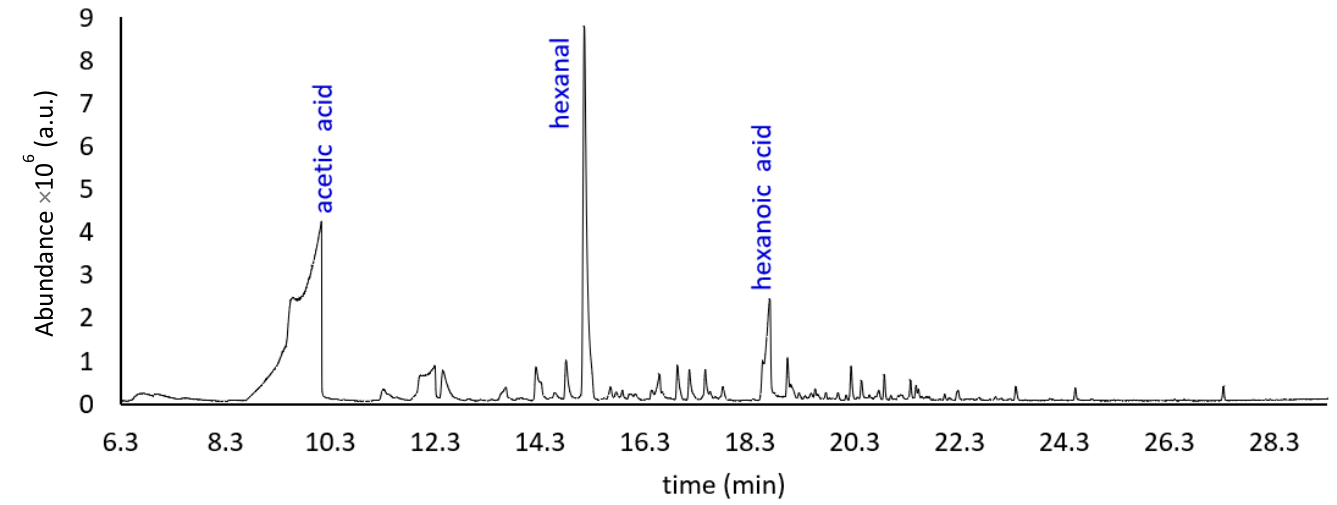
Figure 4. Total ion chromatogram of the VOCs from M_B_O_t 24 fibrous sample, obtained using HS- SPME-GC-MS analysis (a.u. = arbitrary units). Table 3. VOCs of the bleached melon pomace after 24 months of storage (M_B_O_t 24 ) identified through HS-SPME-GC-MS analysis, grouped by chemical classes. Data are expressed as mean ( n = 3) TIC area × 10 6 ± SD (3) .